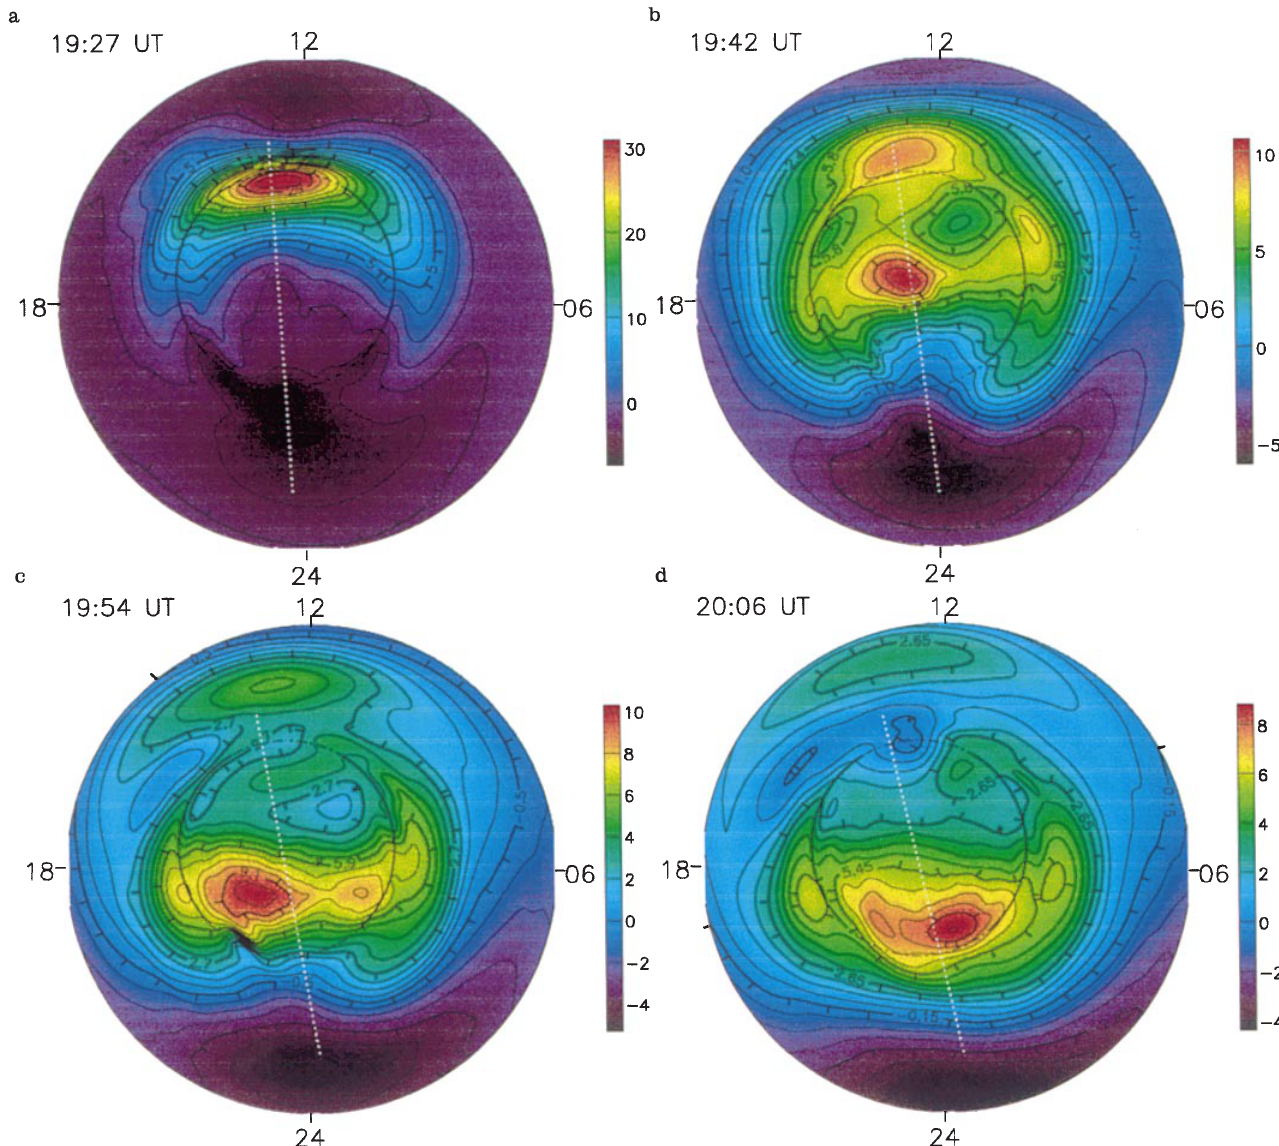
Fig. 5a–d. Polar plots of the perturbation in the height of pressure level 13 at a 1927 UT, b 1942 UT, c 1954 UT, and d 2006 UT. The boundary for all plots is at 50 (cid:14) latitude. The colour scale is di(cid:128)erent for each plot and is shown in km by the colour bar to the right of each . The contours of perturbation heights are also plotted. The bold